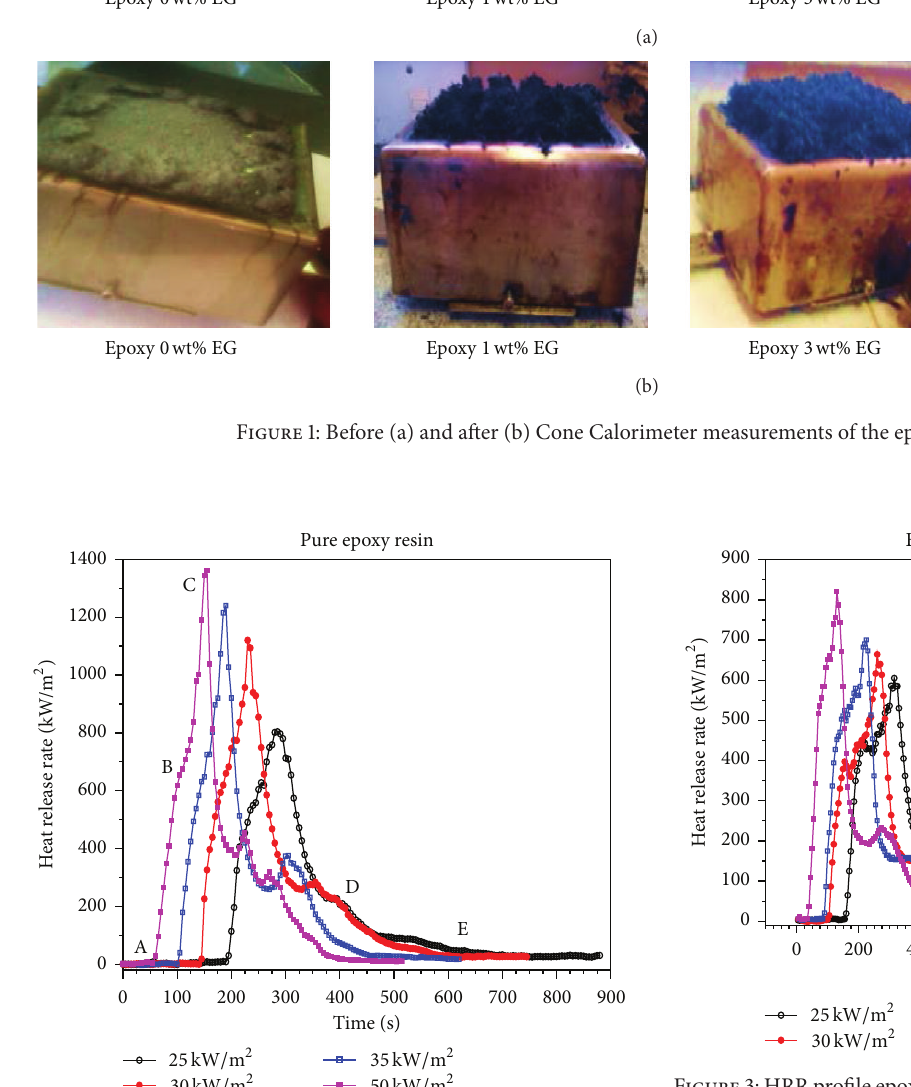
Figure 3: HRR profile epoxy-1 wt.% EG subjected to different exter- nal heat